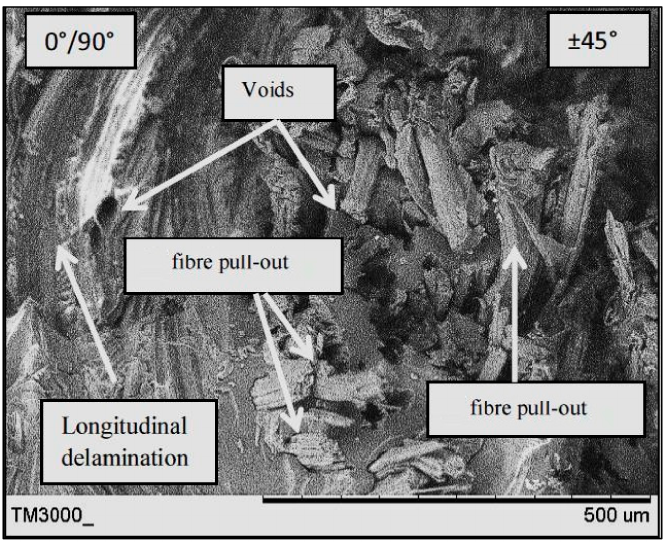
Figure 8. SEM image of PPPP_09045 at a 45% UTS